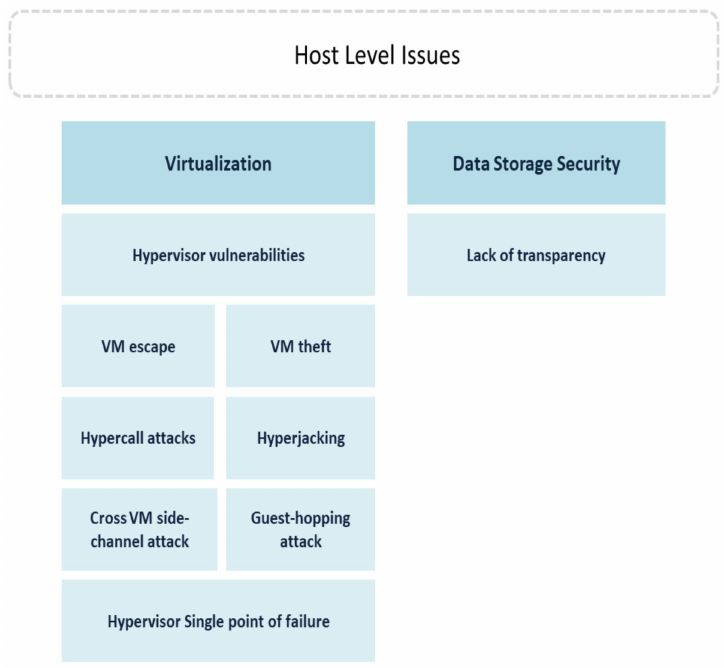
Figure 10. Host Level